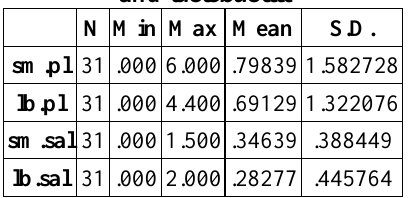
Table 5: Pearson correlation for upper permanent teeth with streptococcus and